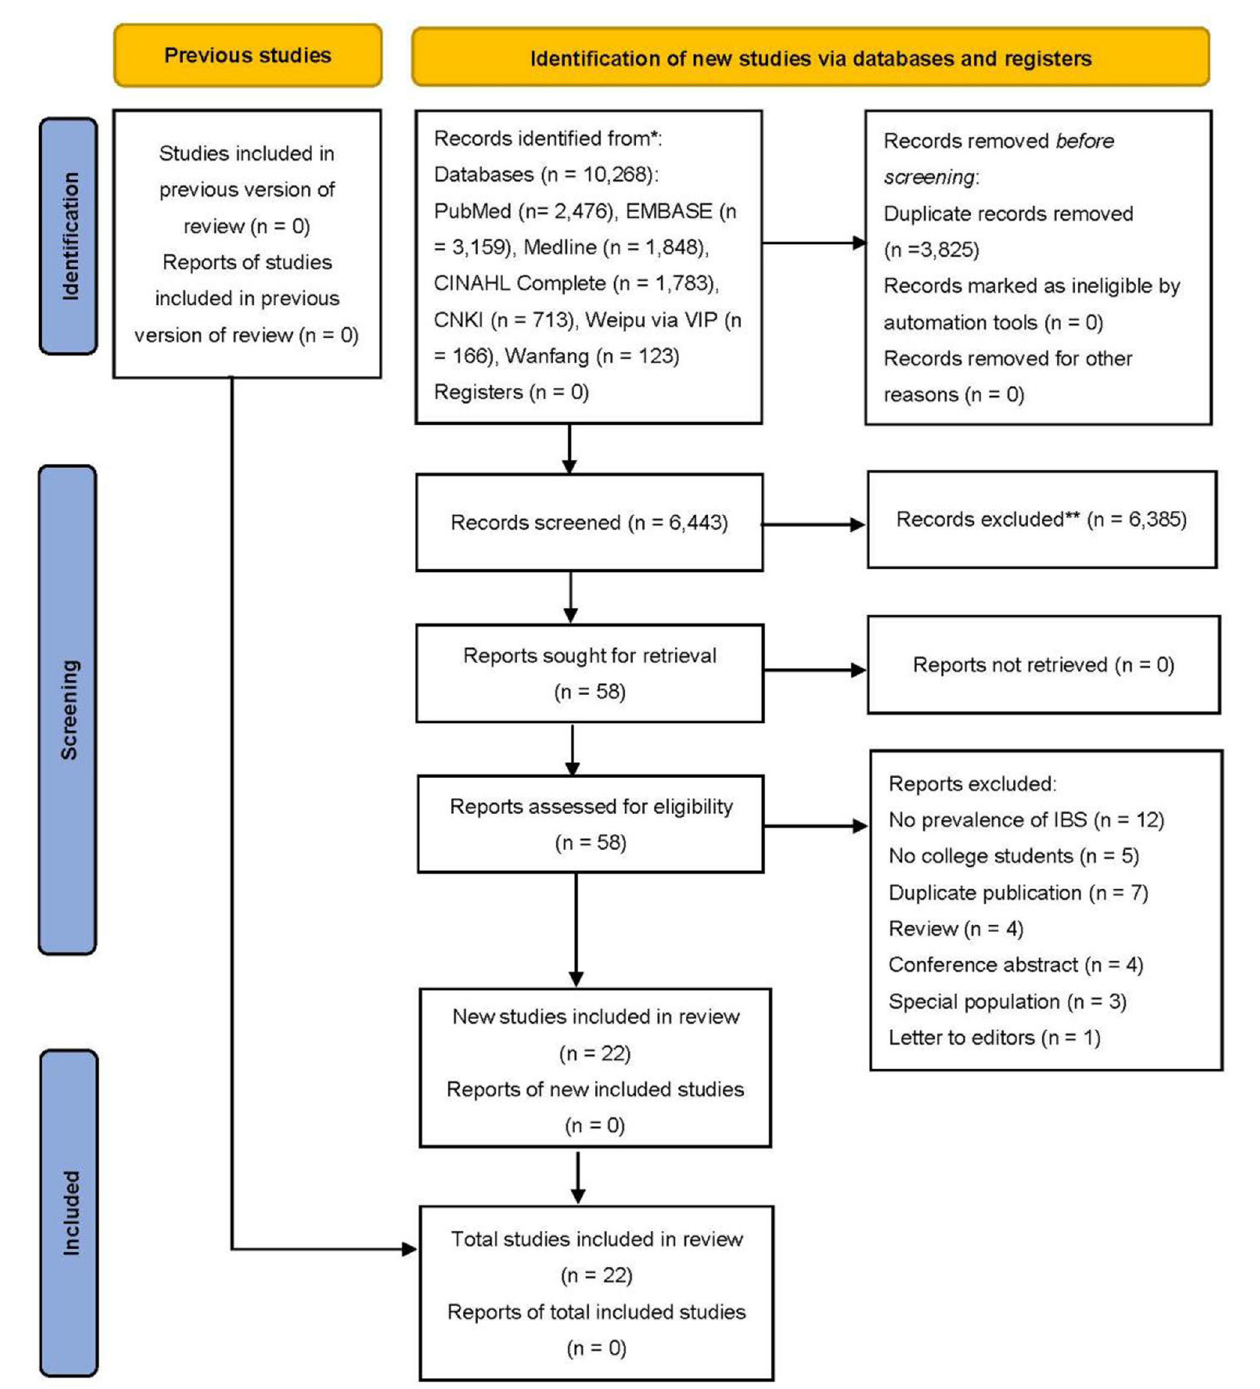
FIGURE 1 | PRISMA flow chart of literature search and article selection process.